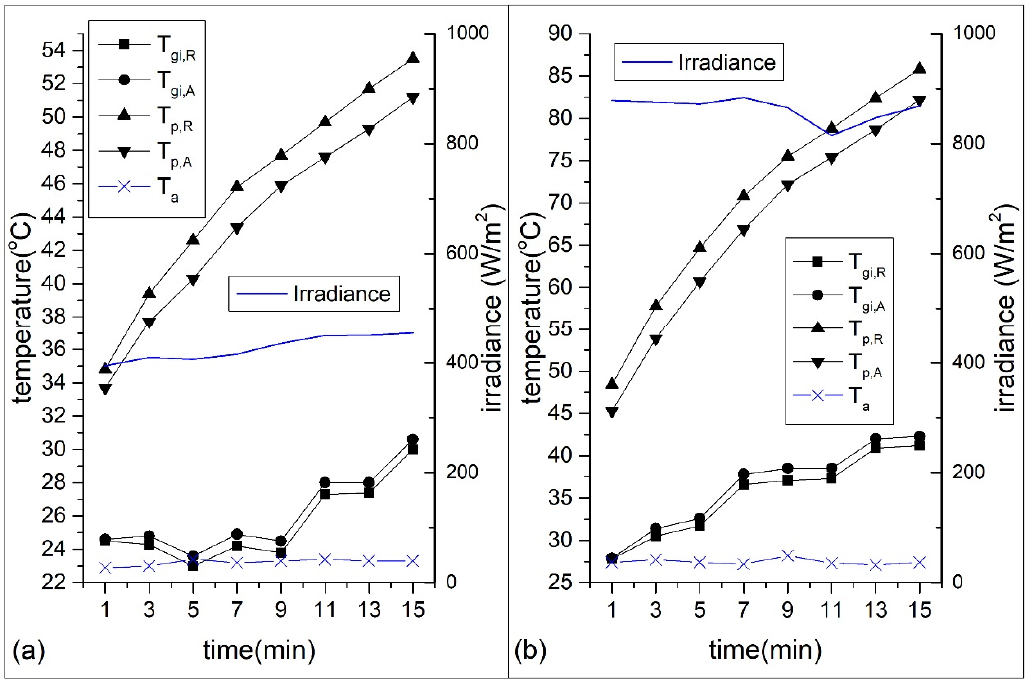
Figure 9. Temperature change in the heating process: ( a ) under low solar irradiance; ( b ) under high solar irradiance.